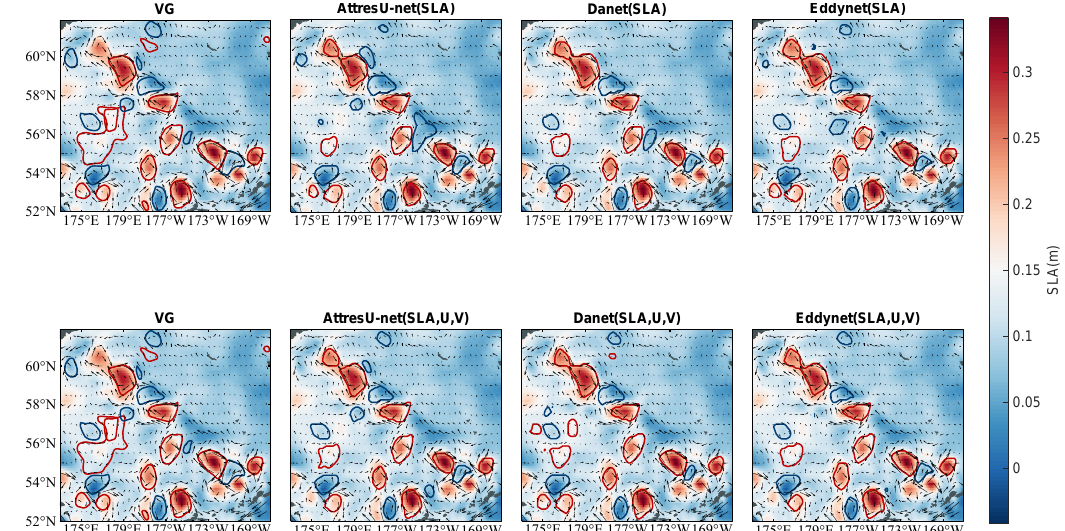
Figure 3. Comparison of the oceanic eddies detected by the four different algorithms in the BSs region on 9 September 2016. The upper panel shows the comparison of the VG, Attresunet, Danet, and Eddynet eddy detection results from the SLA dataset. The bottom panel shows the comparison of the VG, Attresunet, Danet, and Eddynet eddy detection results from the SLA and geostrophic velocity datasets. The shading is SLA, red contours are anticyclonic eddies, and blue contours are cyclonic